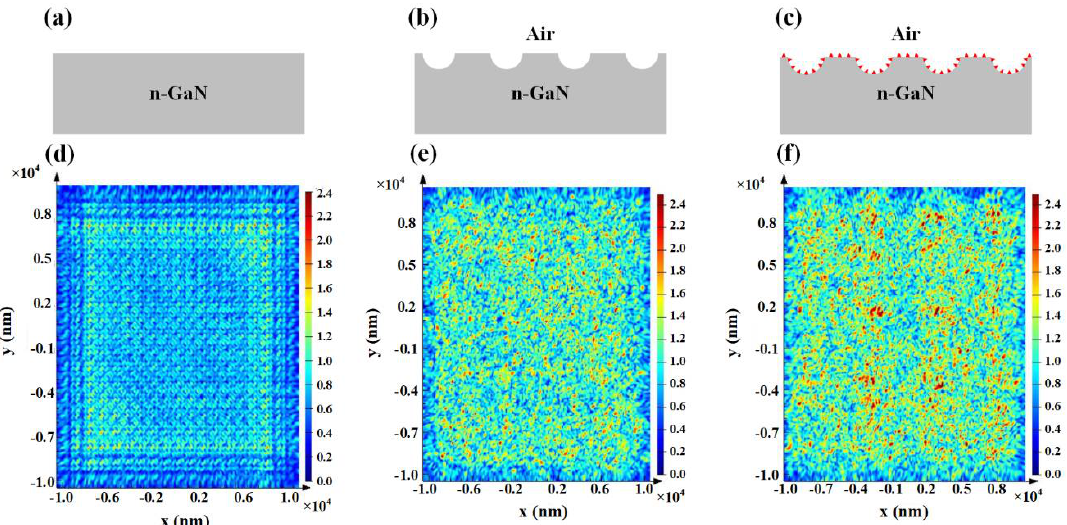
Figure 5. Schematic of the top surface morphologies of fabricated vertical LEDs with ( a ) flat surface, ( b ) single micro-scale surface texture, and ( c ) integrated surface textures. Normalized light-induced electric field intensity distributions on the top surface of n-GaN layer for vertical LEDs with ( d ) flat surface, ( e ) single micro-scale surface texture, and ( f ) integrated surface textures.